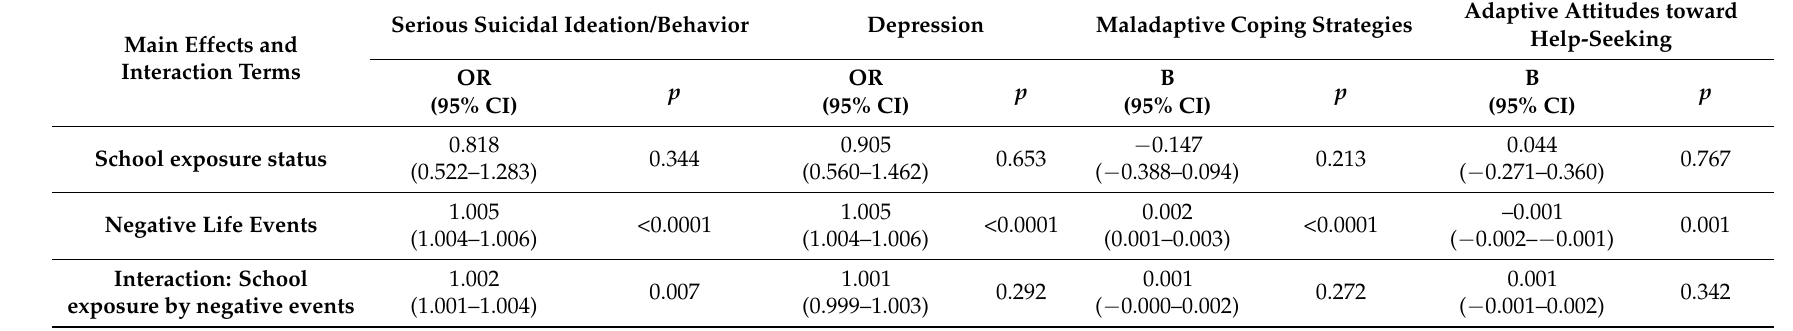
Table 2. Mixed effect regression analyses of serious suicidal ideation/behavior, depression, and attitudes about coping and help-seeking strategies by school exposure and negative life